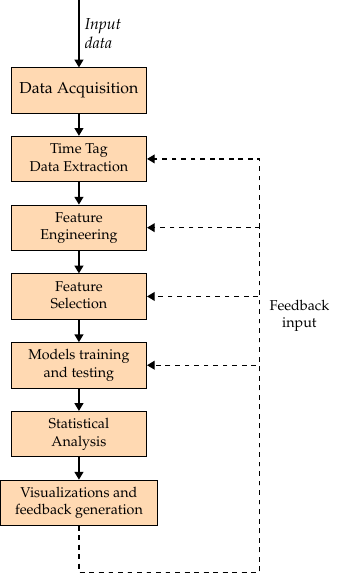
Figure 1. Visualization of the described methodology